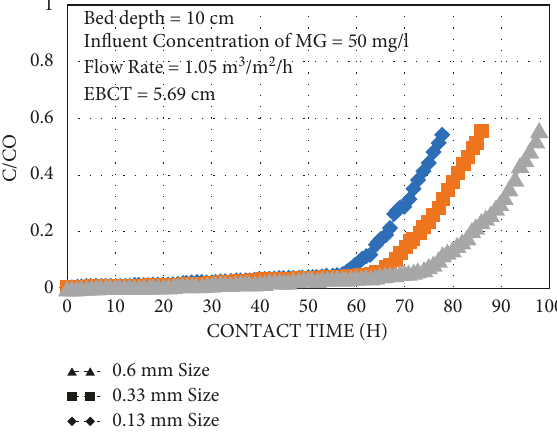
Figure 5: Effect of biosorbent size.